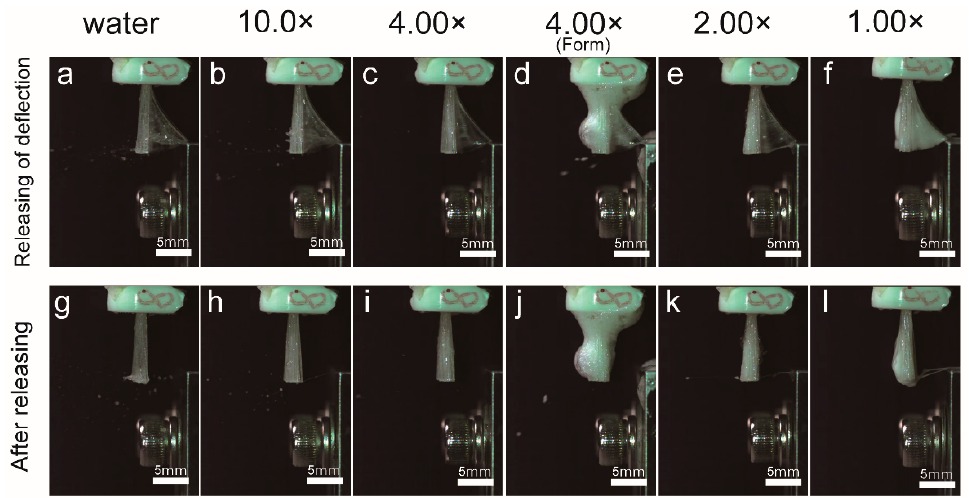
Figure 6. High-speed camera observation at the moment of droplet generation. Images taken with a high-speed camera at the moment and immediately after the droplet formation occurred are shown. ( a – f ) The moment when droplets are generated. ( g – l ) Immediately after the droplets are generated, deflection is released. Scale bars represent 5 mm.